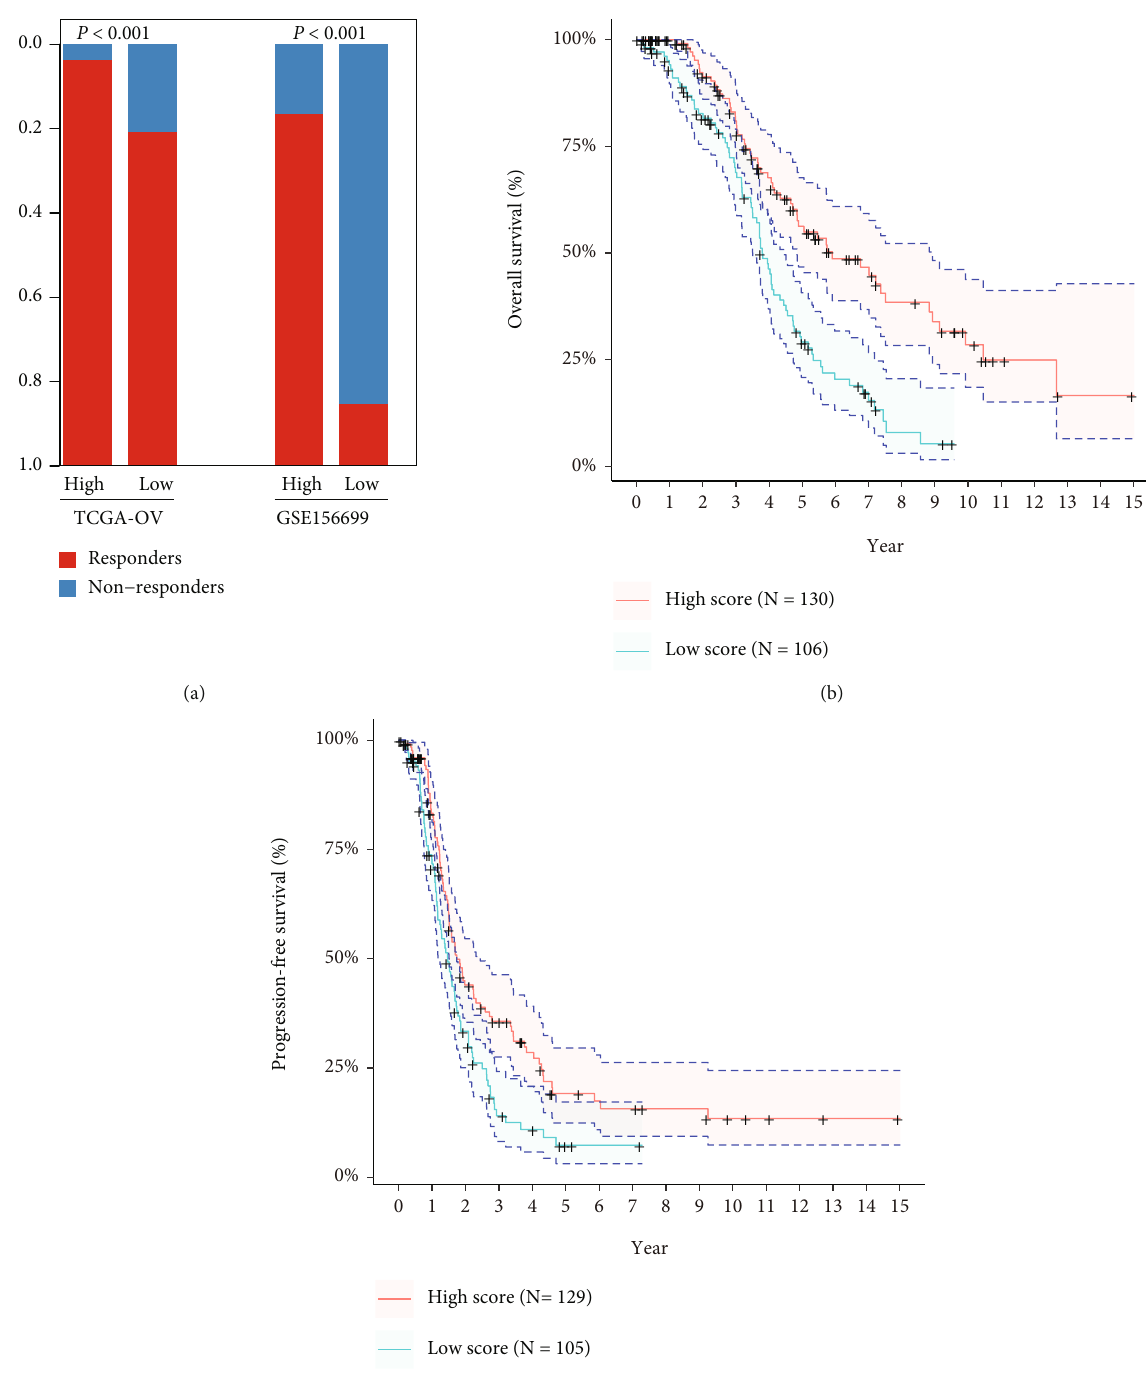
Figure 4: Prognostic analysis of OV samples between high- and low-score groups. (a) The distributions of response and nonresponse samples between high- and low-score groups. (b, c) The overall survival rate and progression-free survival rate of high- and low-score group samples in TCGA-OV dataset. The cross symbols indicated censored samples. The 95% con fi dence intervals were also presented in (b) and